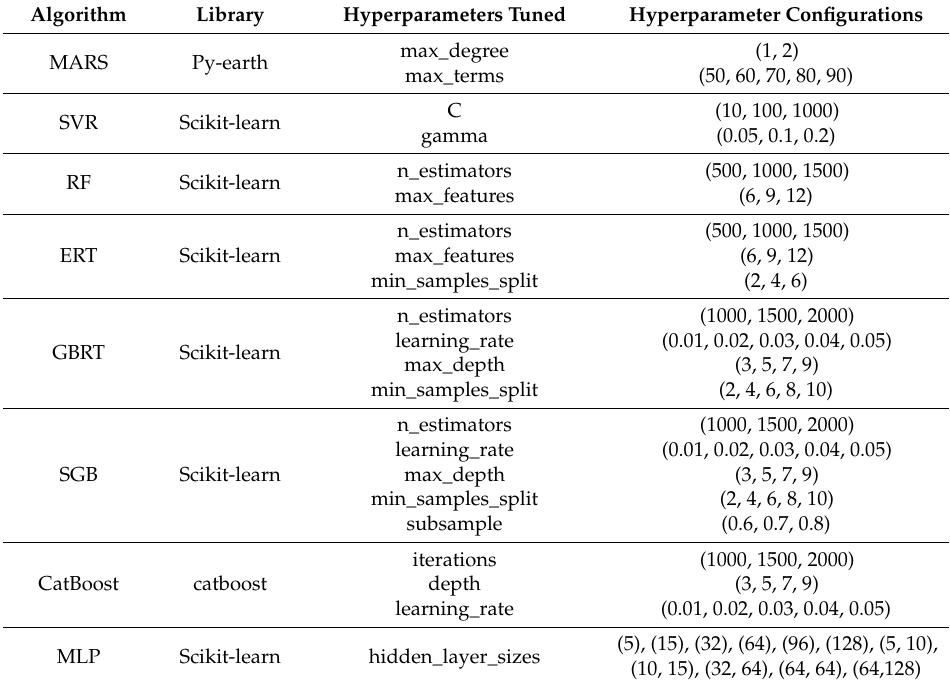
Table 2. Hyperparameters tuned and their configurations for each